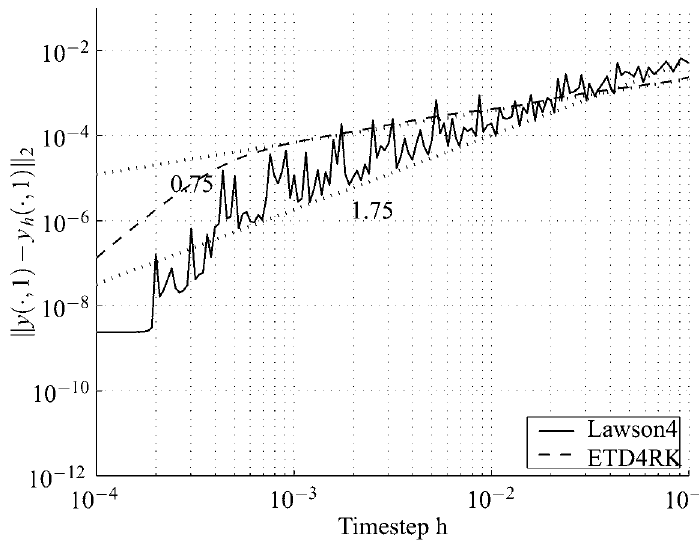
Figure 8. The mixed case: Both the initial condition and the potential has regularity